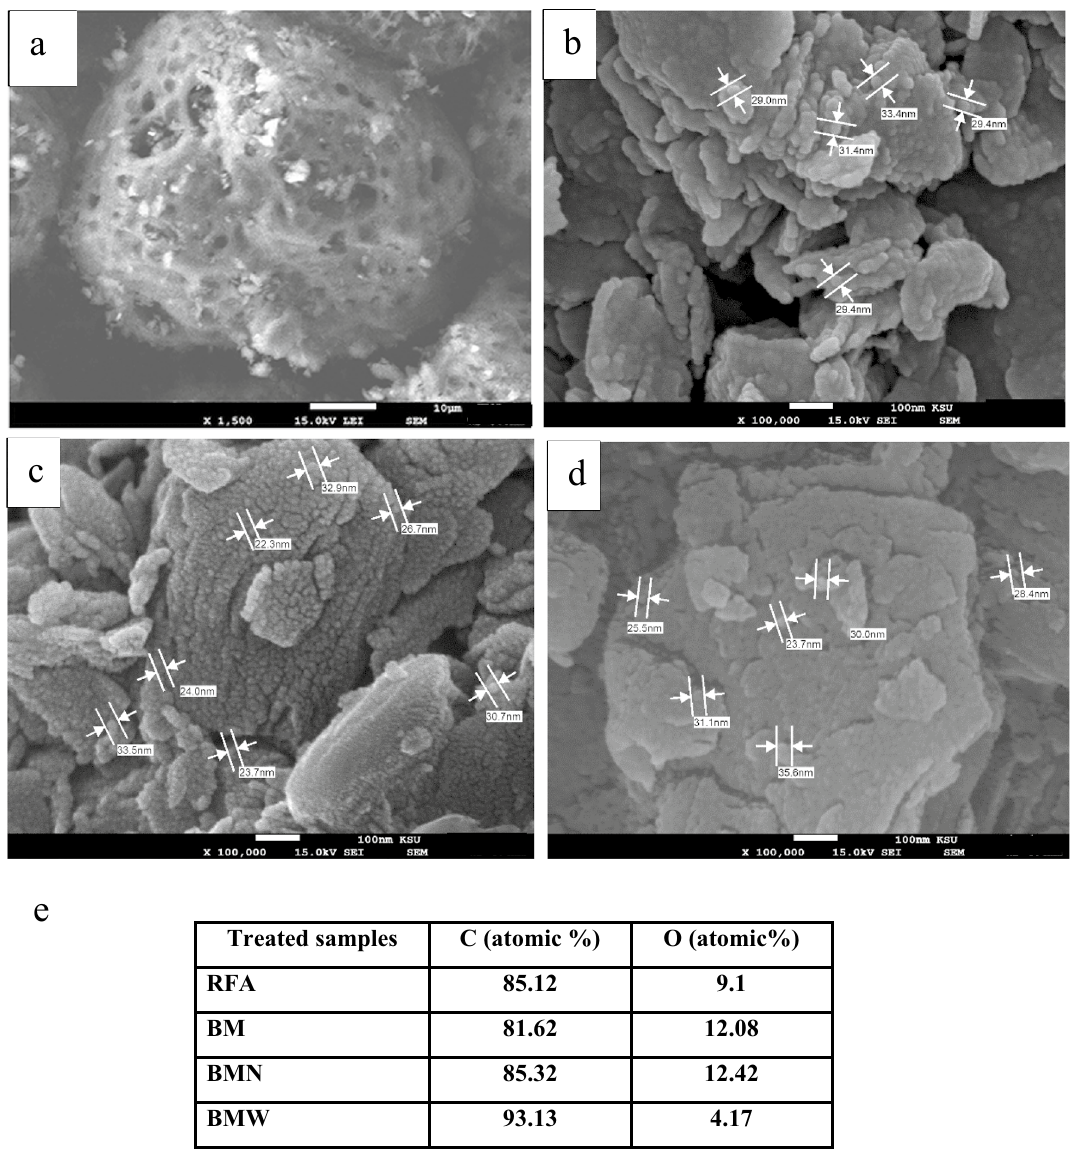
Figure 2. SEM images of ( a ) RFA, ( b ) BM, ( c ) BMN, ( d ) BMW and ( e ) EDS elemental